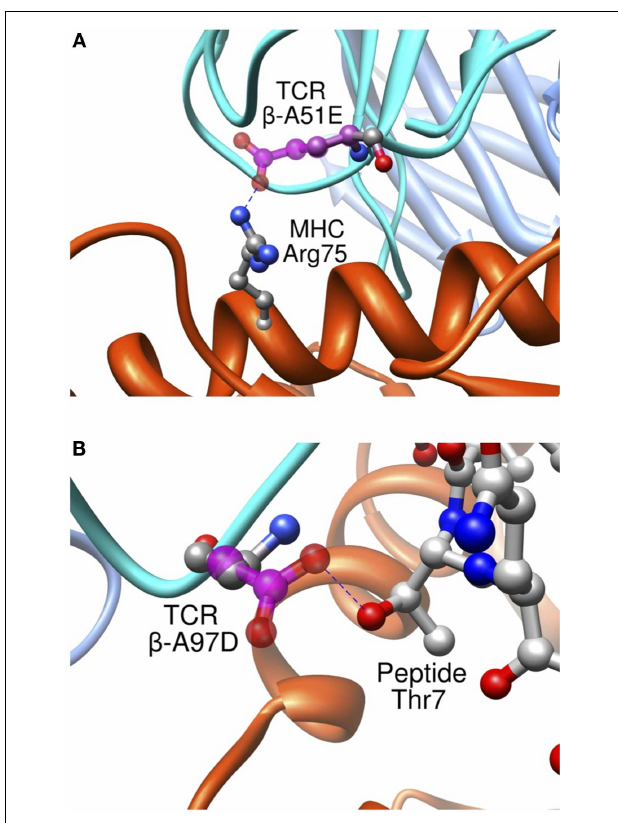
FIGURE 11 | Interaction between pMHC and the modified residues of the β -A51E (A) and β -A97DTCR variants (B) .TCR wild-type residues are shown in ball and stick, colored according to the atom types. Modified residues are colored in magenta. New hydrogen bonds are shown as dotted blue